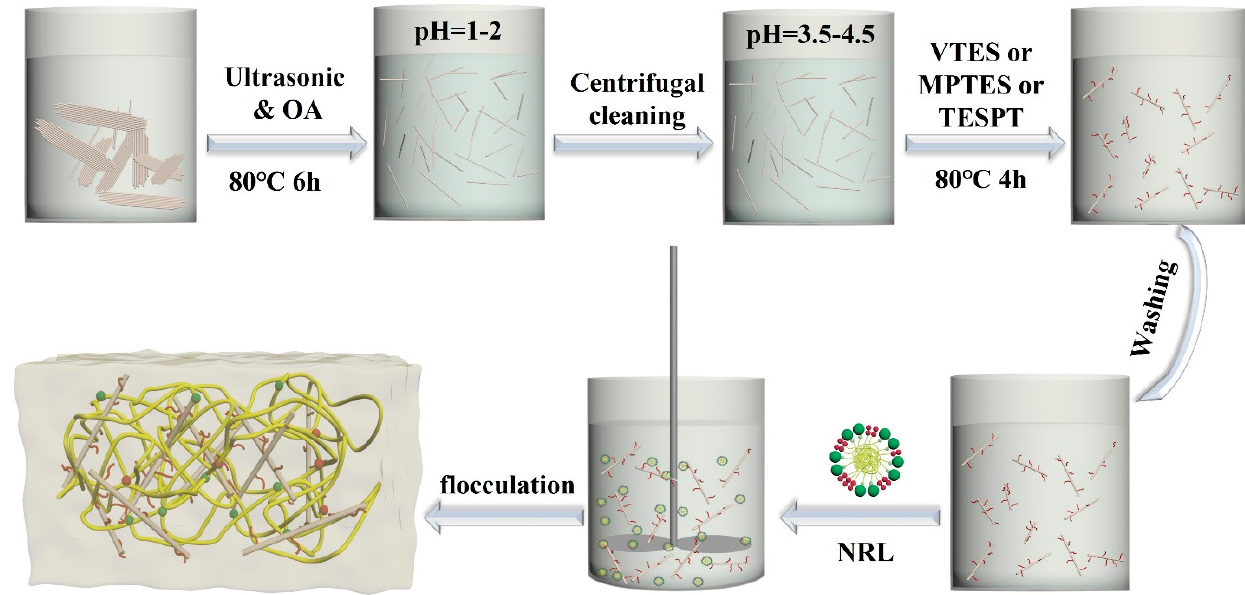
Figure 1. Schematic diagram of sepiolite modification and the latex compounding method.